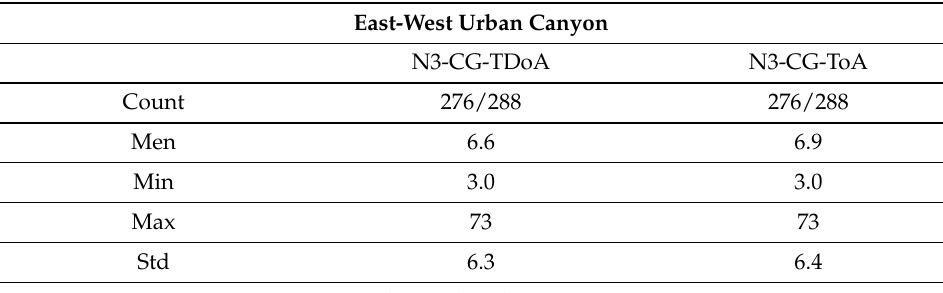
Table 10. Urban canyons: statistical analysis of PDOP for GNSS and three staggered 5G stations (N3) in TDoA (CG-TDoA) abd ToA (CG-ToA) processing.